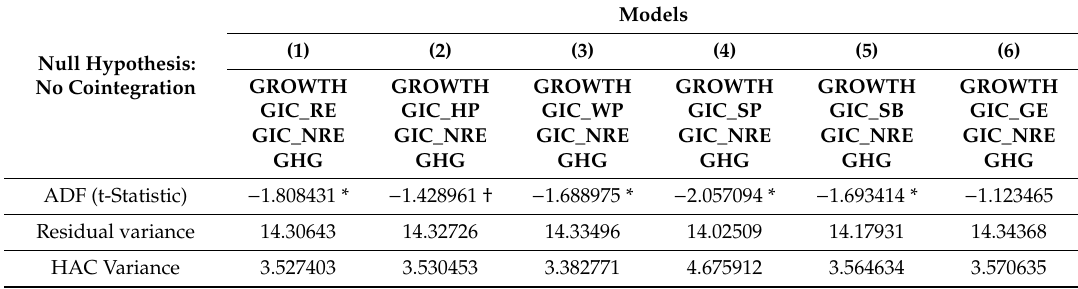
Table 12. Kao panel cointegration results.